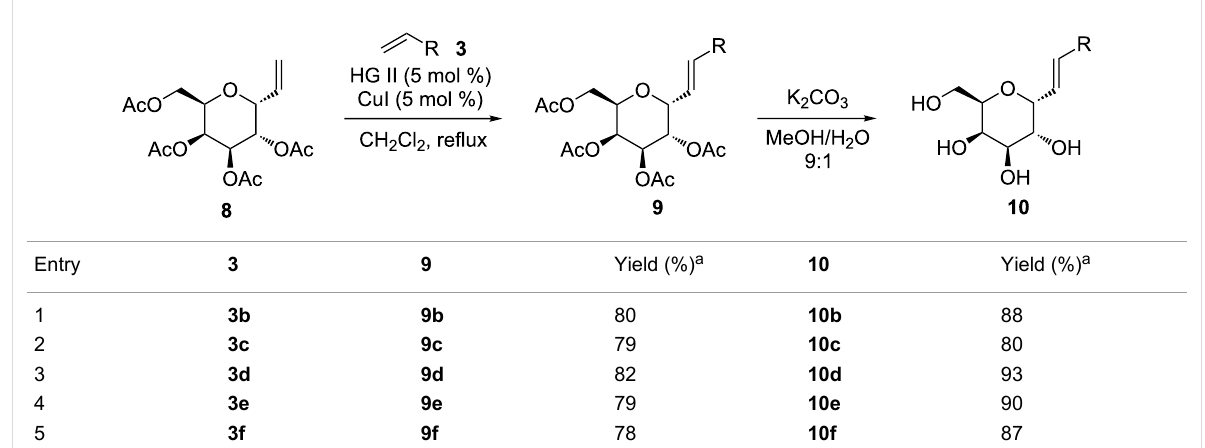
Table 4: Cross-metathesis of 8 with alkenes 3 in the presence of